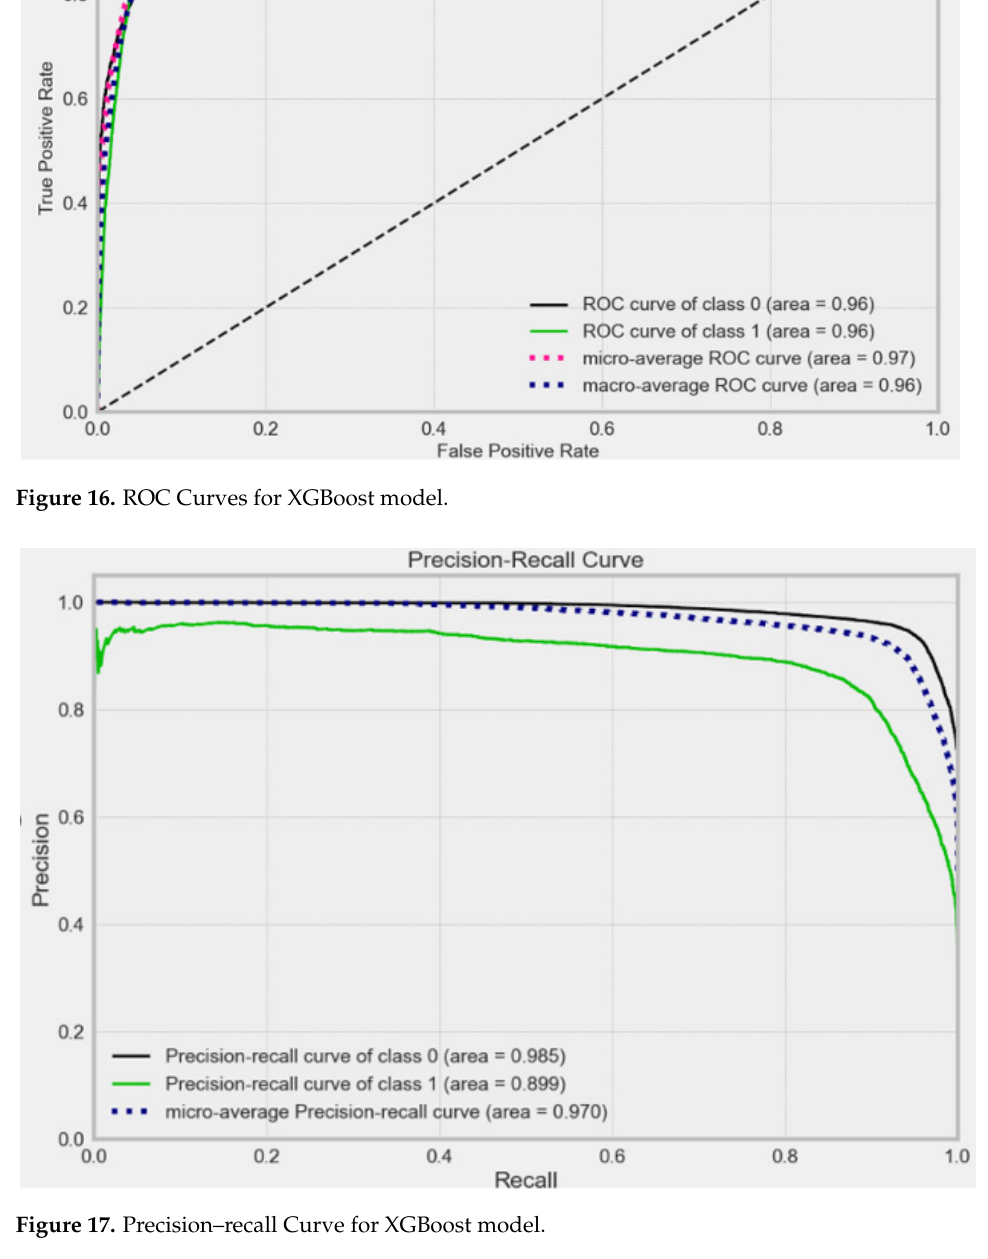
Figure 18. Normalized Confusion matrix for random forest model.